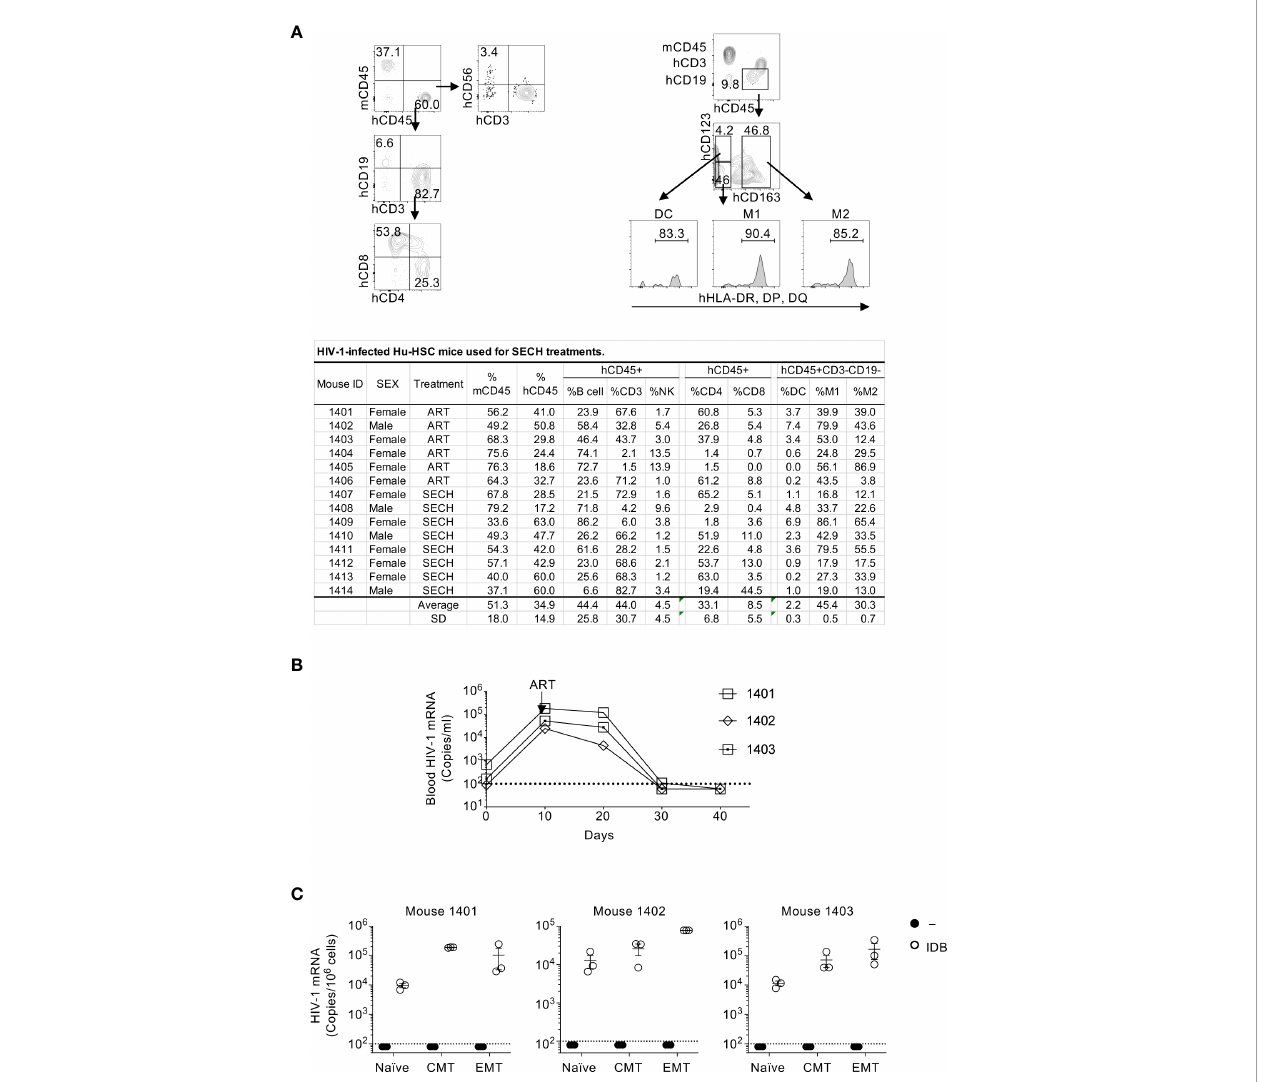
FIGURE 1 HIV-1 latent infection in human T cell subsets of Hu-HSC mice. (A) Hu-HSC mice were produced by reconstituting NSG-SGM3 mice with human CD34 + hemopoietic progenitor cells. Three months after implantation of CD34 cells, human immune cells positive for human CD45 (hCD45 + ) and negative for mouse CD45 (mCD45 – ) in the peripheral blood of Hu-HSC mice was quanti fi ed by fl ow cytometry. The representative plot of fl ow cytometry of Hu-HSC was shown in upper penal, and the quanti fi cation of immune cell populations from each individual mouse was presented in the lower panel. (B) Hu-HSC mice (n=3) were infected with HIV-1 (AD8 strain, 1000 pfu/mouse), followed by ART treatment on day 10 post infection. Peripheral blood was collected, and HIV-1 mRNA in the whole blood of Hu-HSC mice was determined by RT-PCR. (C) Human T cell subsets were sorted from mice in (B) after ART treatments, and re-stimulated with IDB for 24 h, following by measurement of HIV-1 mRNA by RT-PCR. The dash line indicates detection